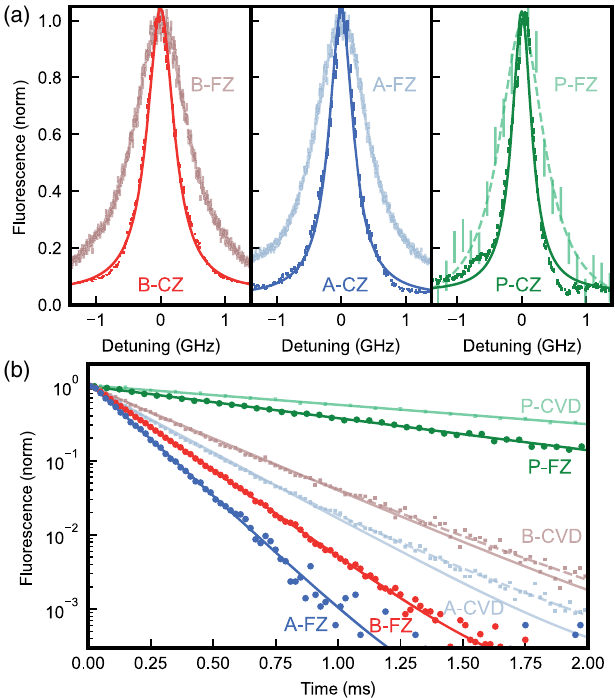
FIG. 3. Inhomogeneous linewidth and optical lifetime. (a) Resonant fluorescence after excitation laser pulses of different frequency. The observed lines are well fit by Lorentzian curves. The observed linewidths in the FZ samples (faint colors) are larger than in the CZ (bright colors) and CVD samples (see Appendix E 2) because of implantation-induced damage. (b) To determine the lifetime, we excite a higher CF level and observe the filtered lowest CF transition. The observed lifetime depends on the site (color) and the waveguide geometry (faint, ridge waveguide; bright, rib waveguide). The slowest decay is observed for site P (green), whereas site A (blue) and B (red) show faster decays. In the ridge waveguides, the spatial variation of the local density of states leads to a slower biexponential (dashed line) rather than a single-exponential (solid line) decay (see Appendix